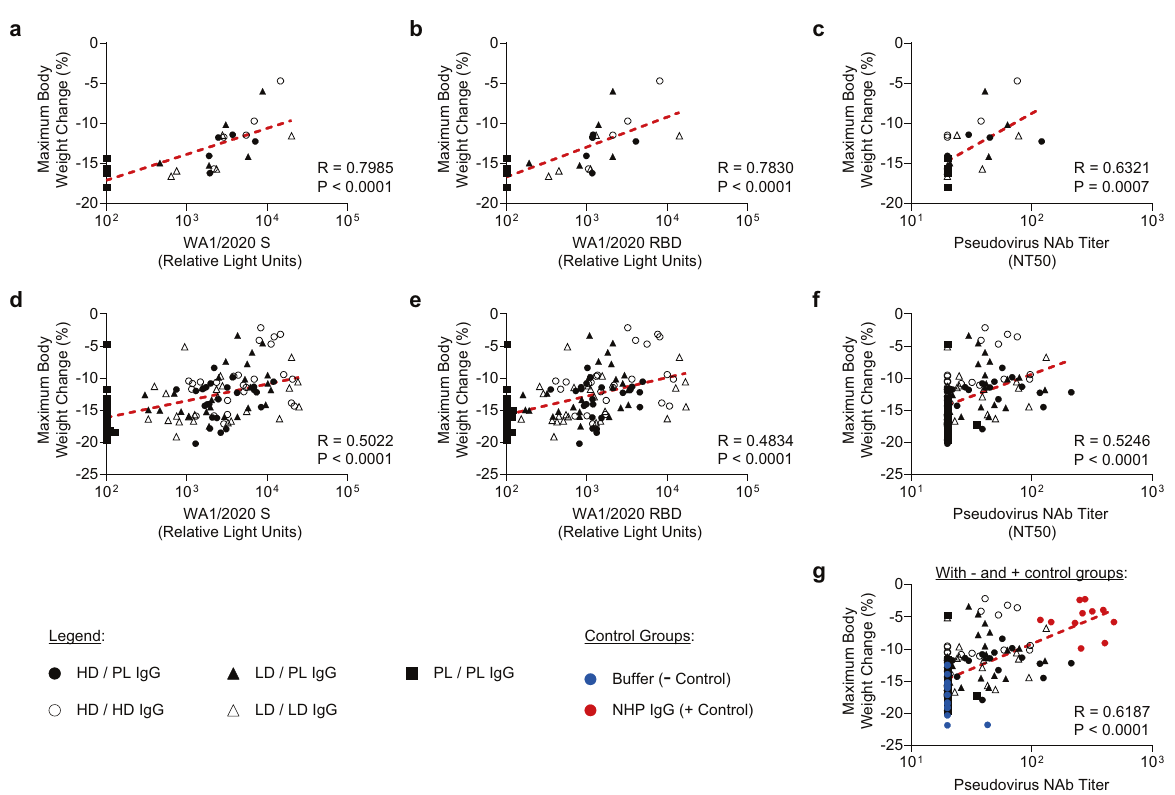
Fig. 3 Post-transfer binding and neutralizing antibody activity correlate with post-challenge body weight loss. Correlation analyses were performed between post-transfer, pre-challenge binding and neutralizing antibody activity and the maximum body weight change following WA1/2020 SARS-CoV-2 challenge. In panels a – c , the median ( a ) WA1/2020 spike (S) or ( b ) WA1/2020 receptor binding domain (RBD) titer or ( c ) the median WA1/2020 pseudovirus neutralization titer was correlated with the median maximum body weight change. Data points displayed correspond to the median values for each group of hamsters corresponding to one study participant. To enable visualization of the full data set, panels d – g display similar analyses, with data points corresponding to all individual hamsters in the study shown. Median maximum body weight change was correlated with ( d ) WA1/2020 S binding, ( e ) WA1/2020 RBD binding, and ( f ) WA1/2020 pseudovirus NT50; data is displayed for all hamsters that received IgG from a vaccinee or placebo control. In panel ( g ) the buffer only and NHP IgG groups are also displayed to enable visualization of the experimental data set overlaid with negative and positive controls. Statistics displayed in all panels indicate the results of Spearman correlation